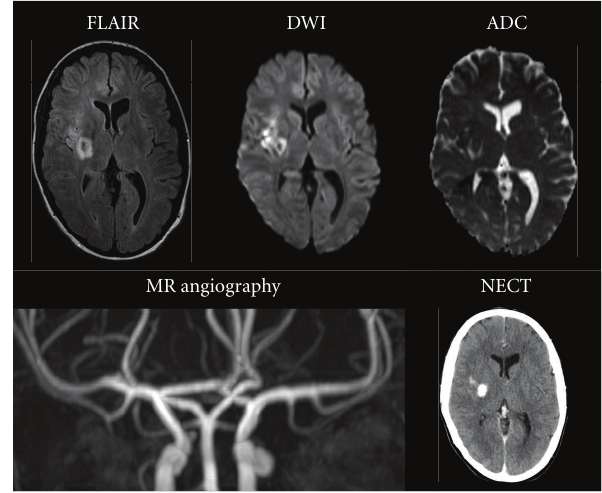
Figure 12: Case 4: follow-up MRI with FLAIR, DWI, ADC showing a relatively small infarction with minor hemorrhage in the right basal ganglia in comparison to the large penumbra seen on the initial CTP examination. The MRA shows complete recanalization of the previously partially revascularized right MCA. NECT shows a small hemorrhagic transformation in the right basal ganglia and parenchymal contrast leakage due to increased permeability secondary to ischemia and